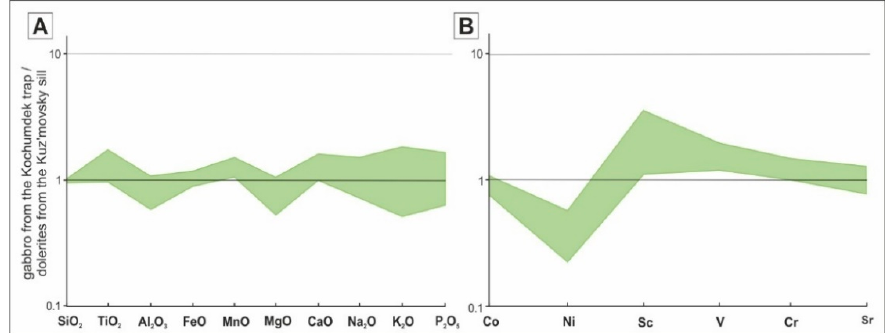
Figure 5. Major ( A ) and trace element ( B ) patterns for gabbro from the Kochumdek trap, normalized to the Kuz’movsky sill roof rocks (interval 0–35 m), after [42]; based on data from Table 1. The Kochumdek gabbro consists of ~32–69% plagioclase, ~22–56% clinopyroxene, and ≤ 6% olivine (Table 2). The majority of plagioclase are fine-grained, interstitial and low-silica varieties, while coarser laths are commonly intergrown with olivine or clinopy- roxene (Figure 3I,J). Other phases include minor amounts of coarse flaky biotite (2–10%), as well as brown or greenish-blue acicular amphibole (1–5%) and chlorite (1–4%) that replace pyroxenes. The main accessory minerals are Ti-bearing magnetite, ilmenite, pyrrhotite, chalcopyrite and Cl-bearing fluorapatite. Titanite and pentlandite are sporadic, whereas baddeleyite, zircon, allanite-(Y), zirconolite, sphalerite, cobaltite, troilite and pyrite oc- cur as individual tiny grains (Table 2). Olivine is mostly fayalitic (Fa 66–69 ) with